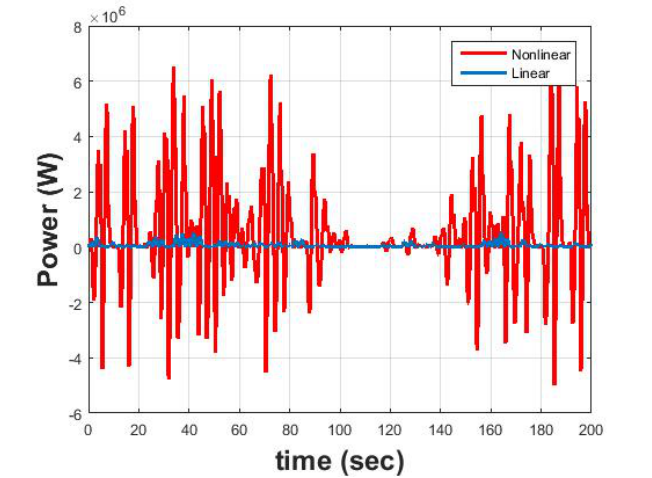
Figure 16. Comparison between the linear and nonlinear WECs in irregular waves: extracted energy.